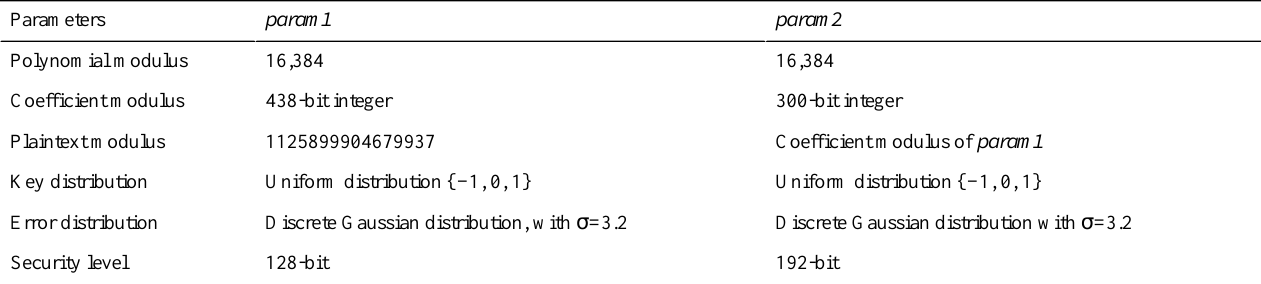
param2param1 Parameters